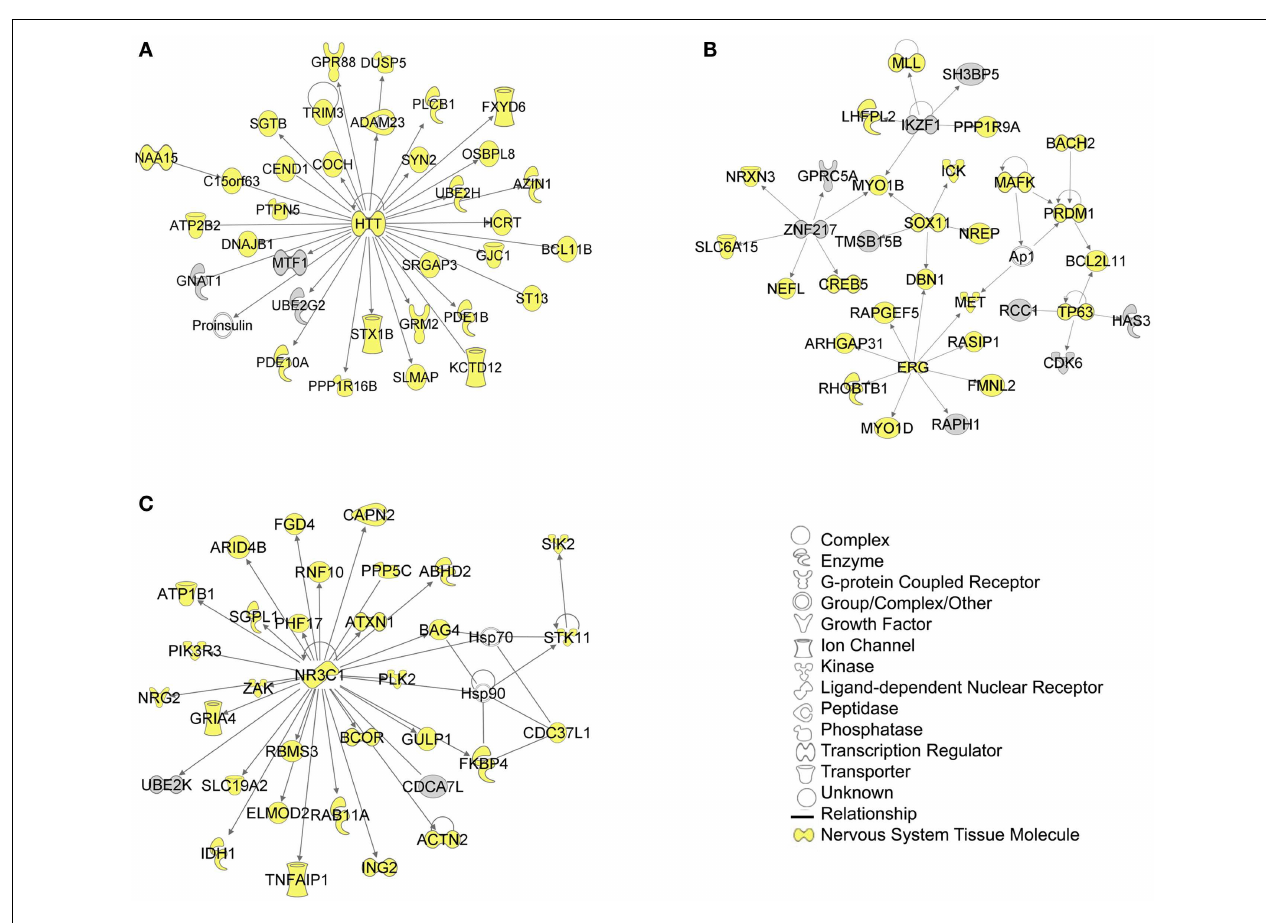
function, and lipid metabolism,” with a score of 36.Yellow indicate molecules expressed in the nervous system.White molecules are those not included in the uploaded dataset but added by IPA. Gray molecules indicate those that were included in the uploaded dataset. Relationships depicted by lines with arrows represent “act on,” while lines without arrows represent binding. See figure keys for identification of the types of molecules